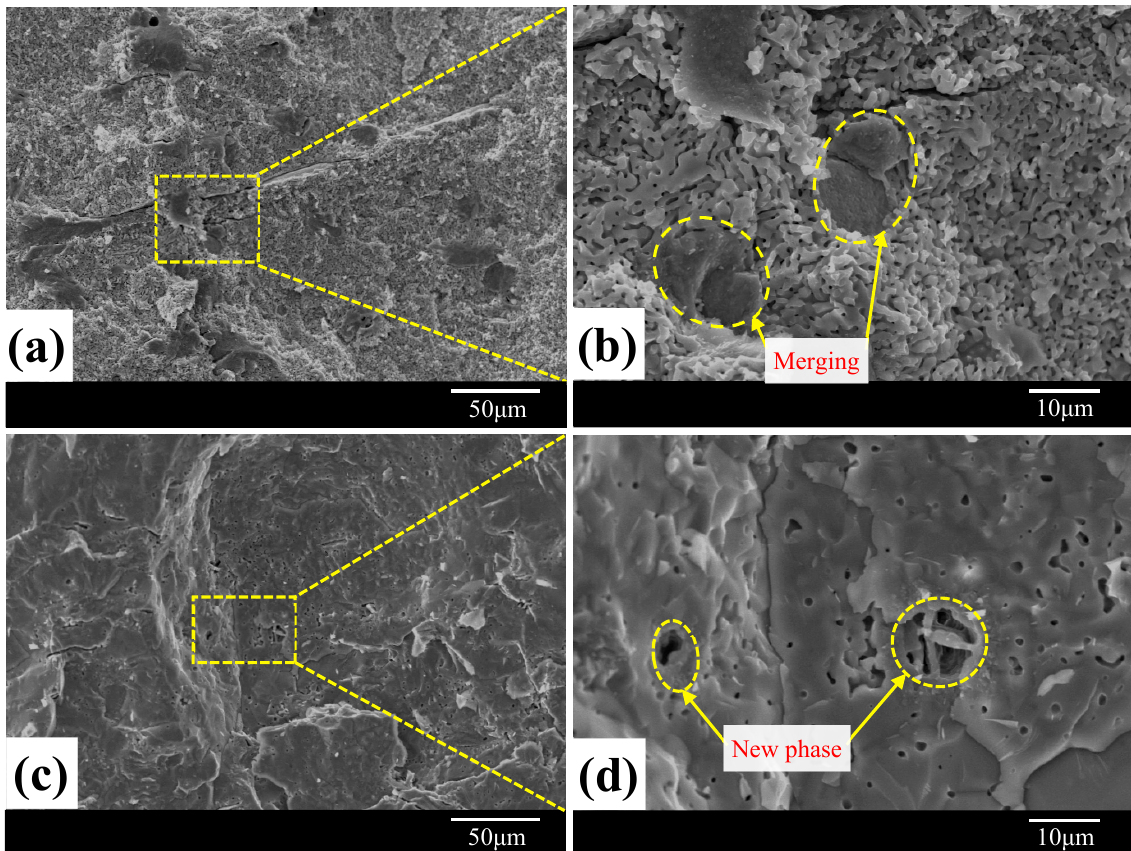
Figure 4. SEM images of MF/HA composites after sintering at different temperatures with 10 wt% MF content: ( a , b ) 1250 °C; ( c , d ) 1350 °C.